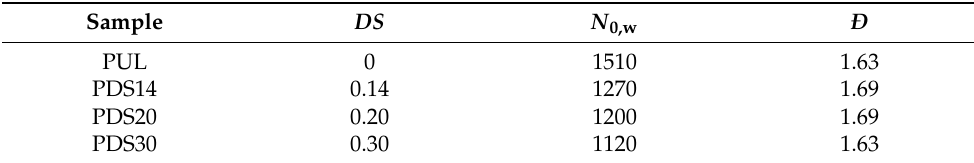
Table 2. Molecular characteristics of PUL and PUL-OSA samples.